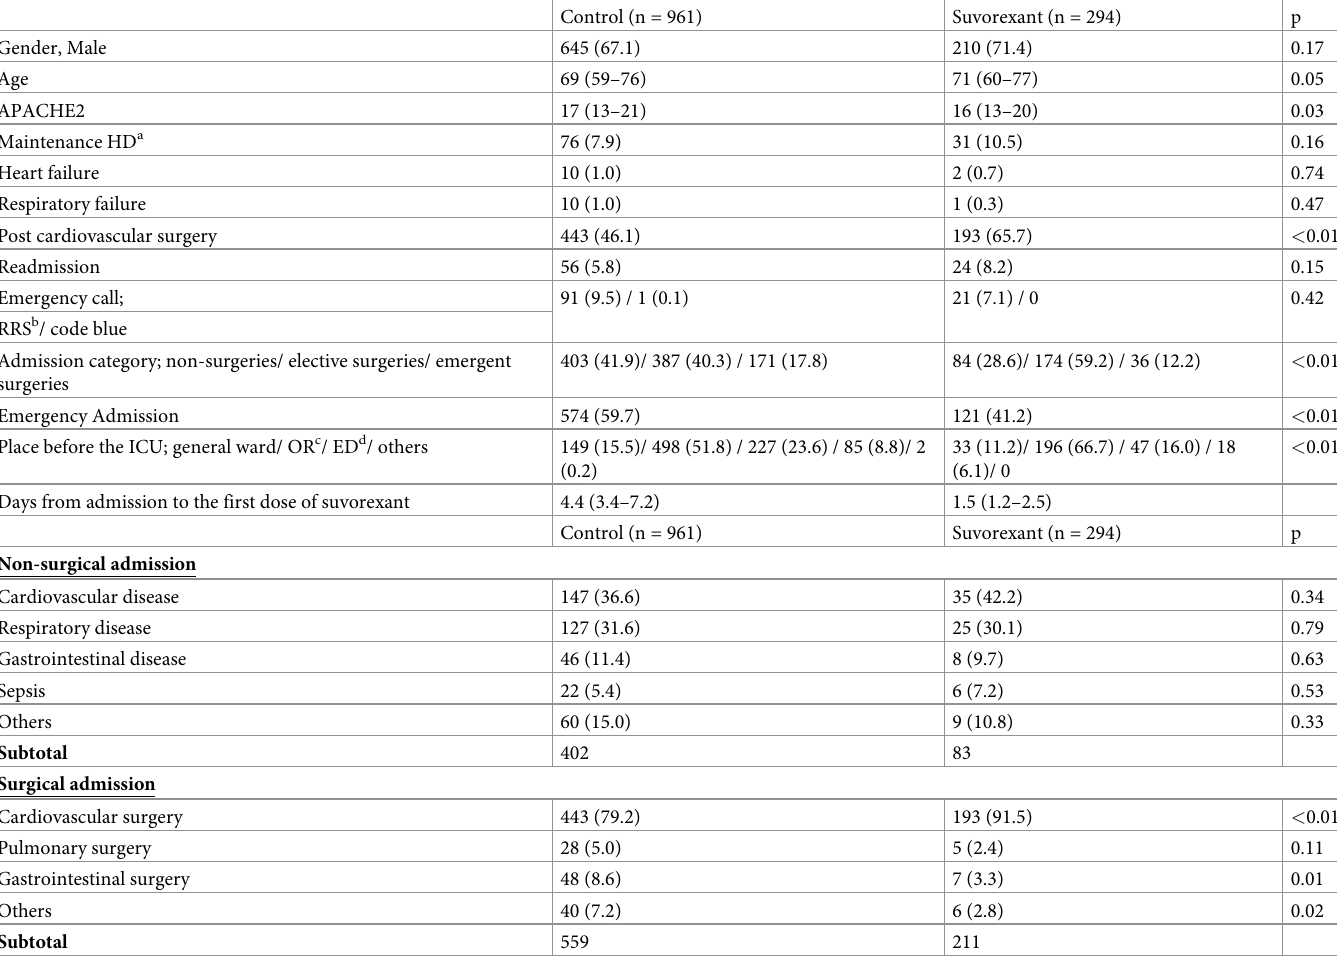
Table 2. Patient